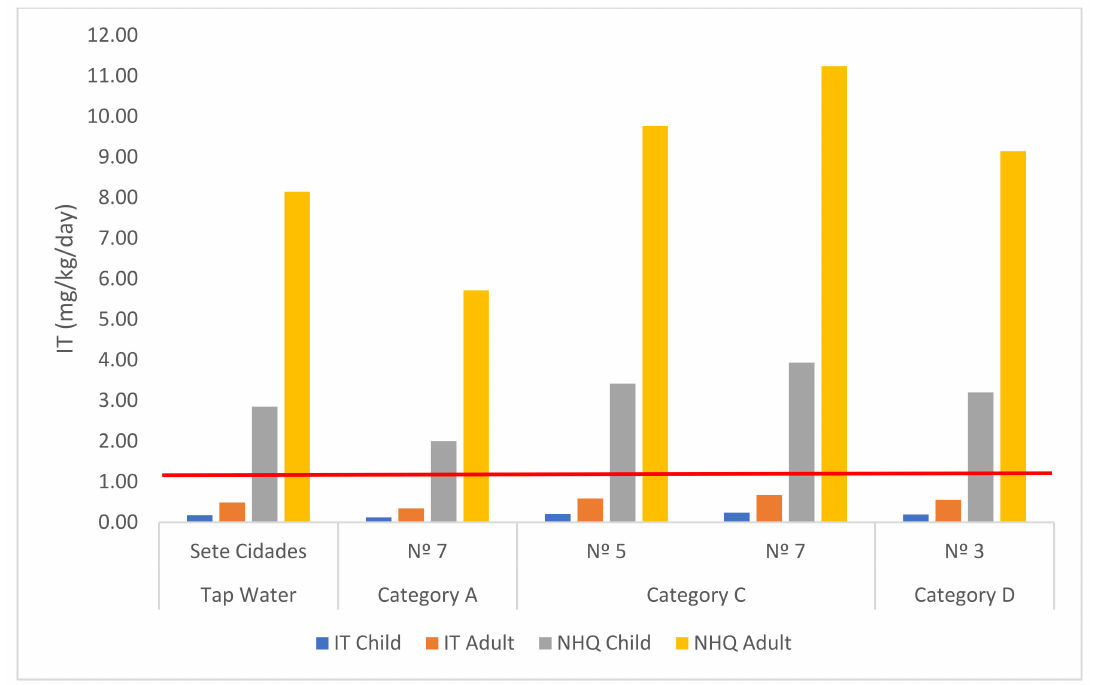
Figure 2. Representation of the exposure assessment (mg/kg/day) and the risk assessment, in lines, for both adults and children. The red line marks the NHQ value of 1 (unit); values above this baseline value denote the possible occurrence of non-cancer